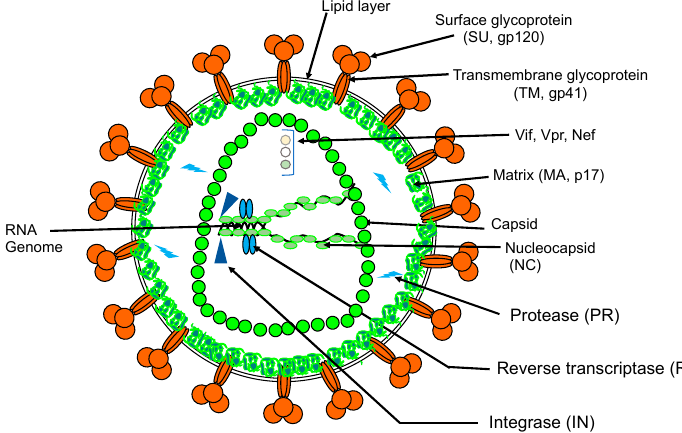
Figure 3. Simplified schematic representation of HIV-1 particle.